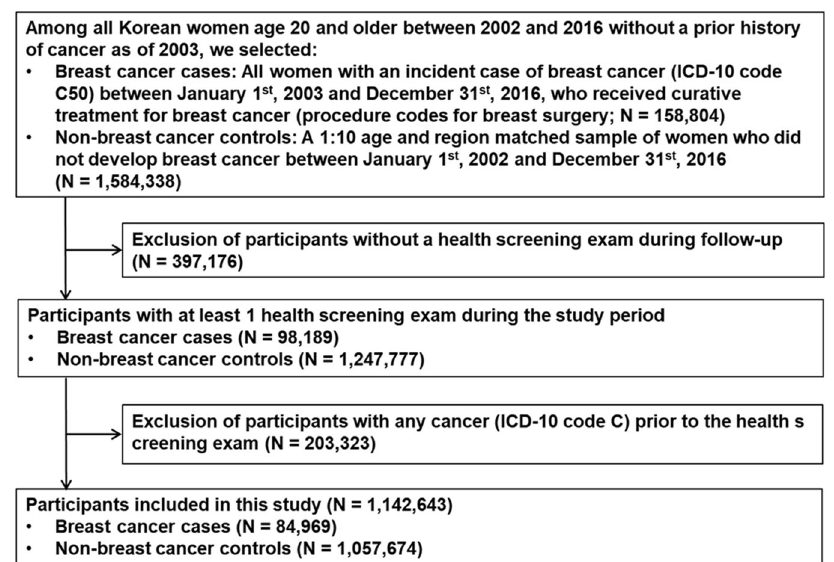
Fig. 1 Flow chart of the study